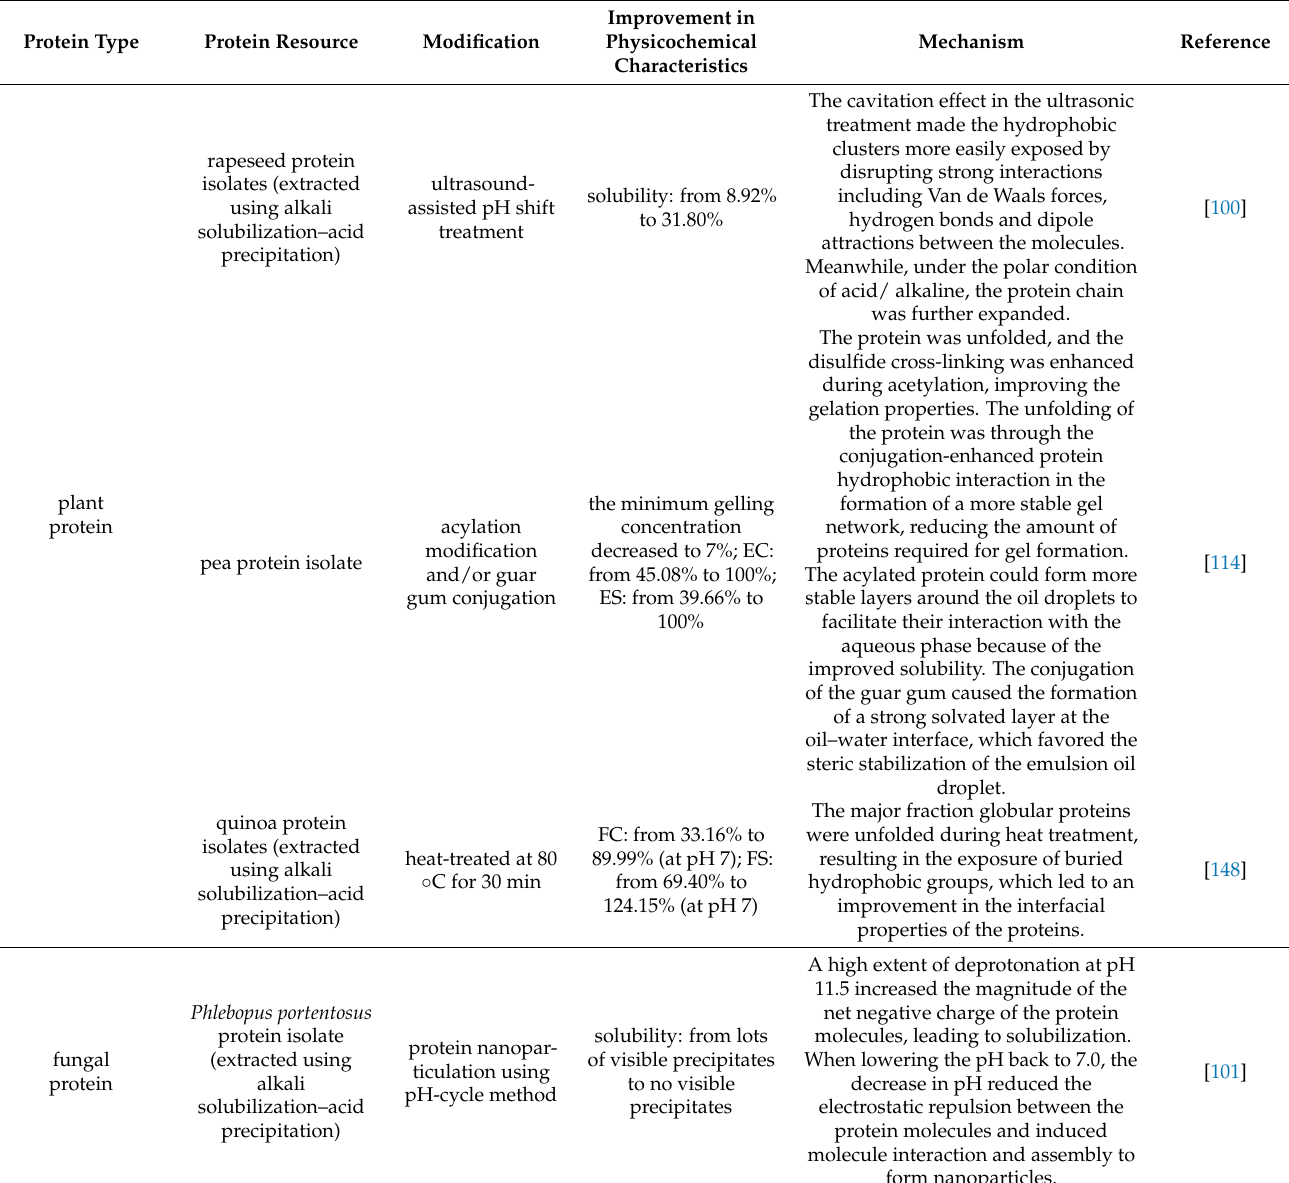
Table 3. Examples of the improvement in the physicochemical characteristics of alternative proteins through modification